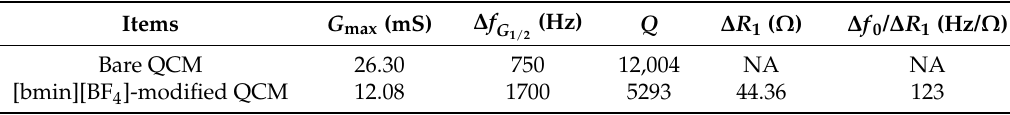
Figure 1. Effect of the presence of the [bmim][BF 4 ] film on the conductance spectrum of quartz crystal in air: ( a ) bare QCM; ( b ) [bmim][BF 4 ] film-modified QCM. Table 1. Comparison of bare and modified QCM in air by